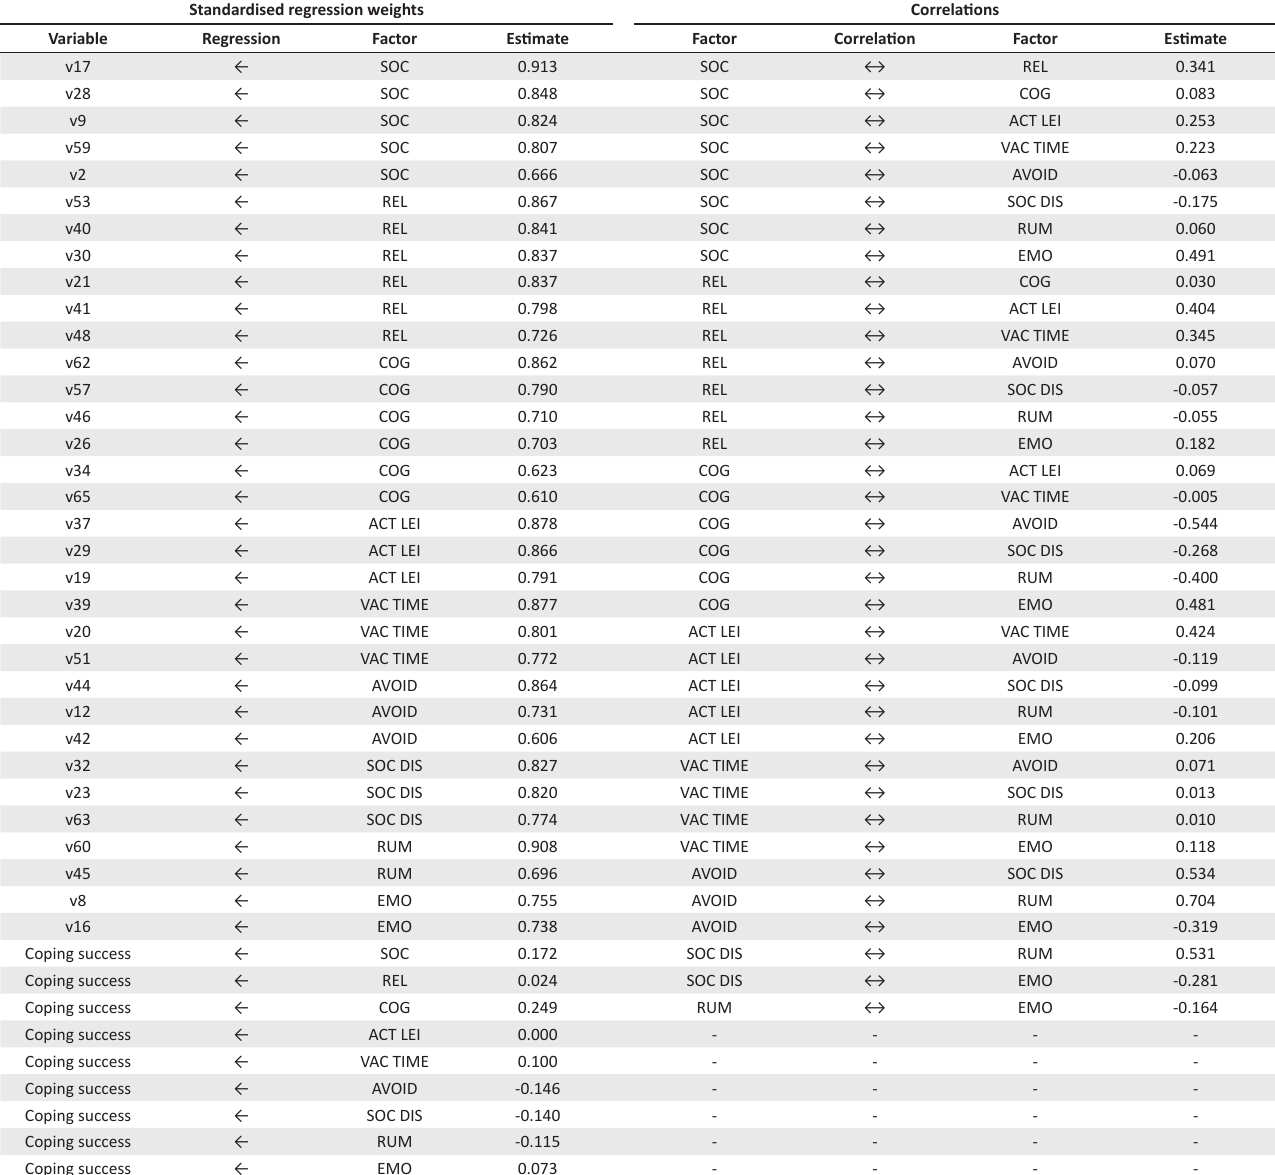
TABLE 5: Standardised regression weights and correlations. Standardised regression